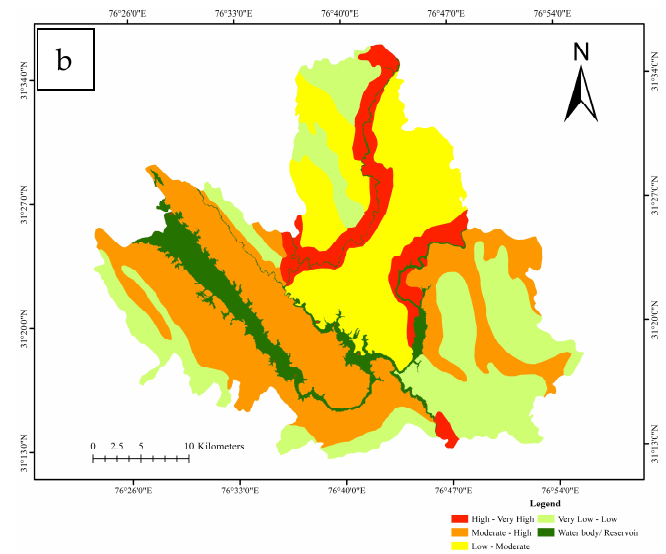
Figure 10. ( a ) Soil map of Bilaspur district; ( b ) Soil index map of Bilaspur district.